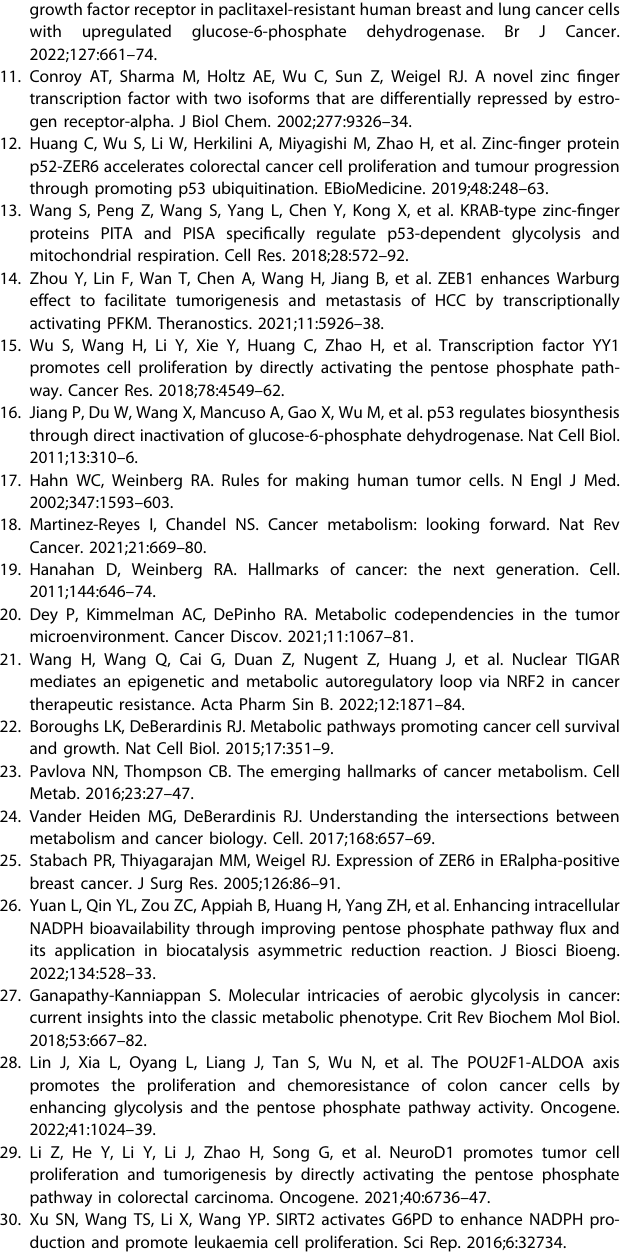
Fig. 6 p52-ZER6/G6PD axis enhances the tumorigenic potential of CRC cells in a p53-independent manner. A p52-ZER6 and G6PD mRNA expression levels in clinical colorectal cancer and corresponding adjacent tissues, as analyzed using qRT-PCR ( n = 21). B Expression levels of p52-ZER6 and G6PD in clinical colorectal cancer and corresponding adjacent tissue, as examined using in situ hybridization assay and immunohistochemistry staining using serial sections, respectively (scale bars: 50 μ m). C p52-ZER6 and G6PD protein expression levels in clinical colorectal cancer and corresponding adjacent tissues, as determined using western blotting ( n = 8). D , F Tumorigenesis potentials of p52 - ZER6 -knocked down HCT116 p53null and p52-ZER6 -knocked down, G6PD -overexpressed HCT116 p53null stable cell lines, as examined in vivo by xenograft experiments (n = 6). Tumor volume at indicated time points ( D ), representative morphological images ( E ), and tumor weight ( F ) at day 27 after transplantation are shown. G Expression levels of p52-ZER6 and G6PD in the xenografted tumors formed by indicated cells, as examined using in situ hybridization assay and immunohistochemistry staining using serial sections, respectively (scale bars: 50 μ m). H p52- ZER6 and G6PD protein expression levels in the xenografted tumors formed by indicated cells, as determined using western blotting. I ROS levels in the xenografted tumors formed by indicated cells (scale bars: 100 μ m). J Schematic diagram showing the molecular mechanism of p52-ZER6 on CRC tumorigenesis via direct transcriptional regulation on G6PD . Cells transfected with shCon and pcCon were used as controls. β -actin was used for qRT-PCR normalization and as western blotting loading control. Quanti fi cation data are expressed as mean ± SD. shp52: shRNA expression vector targeting p52-ZER6 ; pcCon: pcEF9-Puro; pcG6PD: G6PD overexpression vector; ** P <